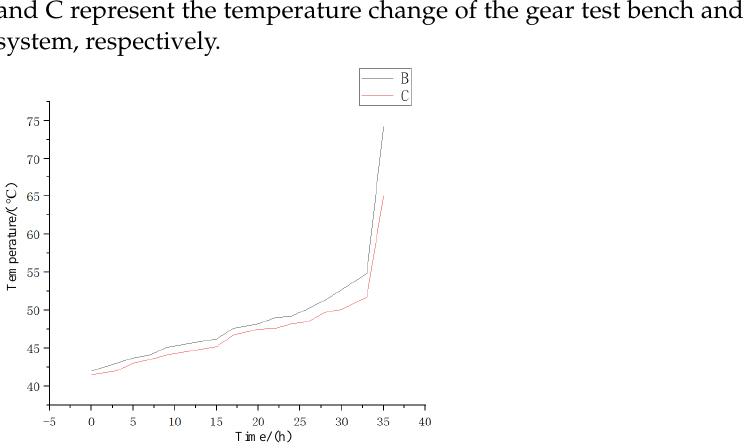
Figure 10. Test bench of spiral bevel gear fatigue life.